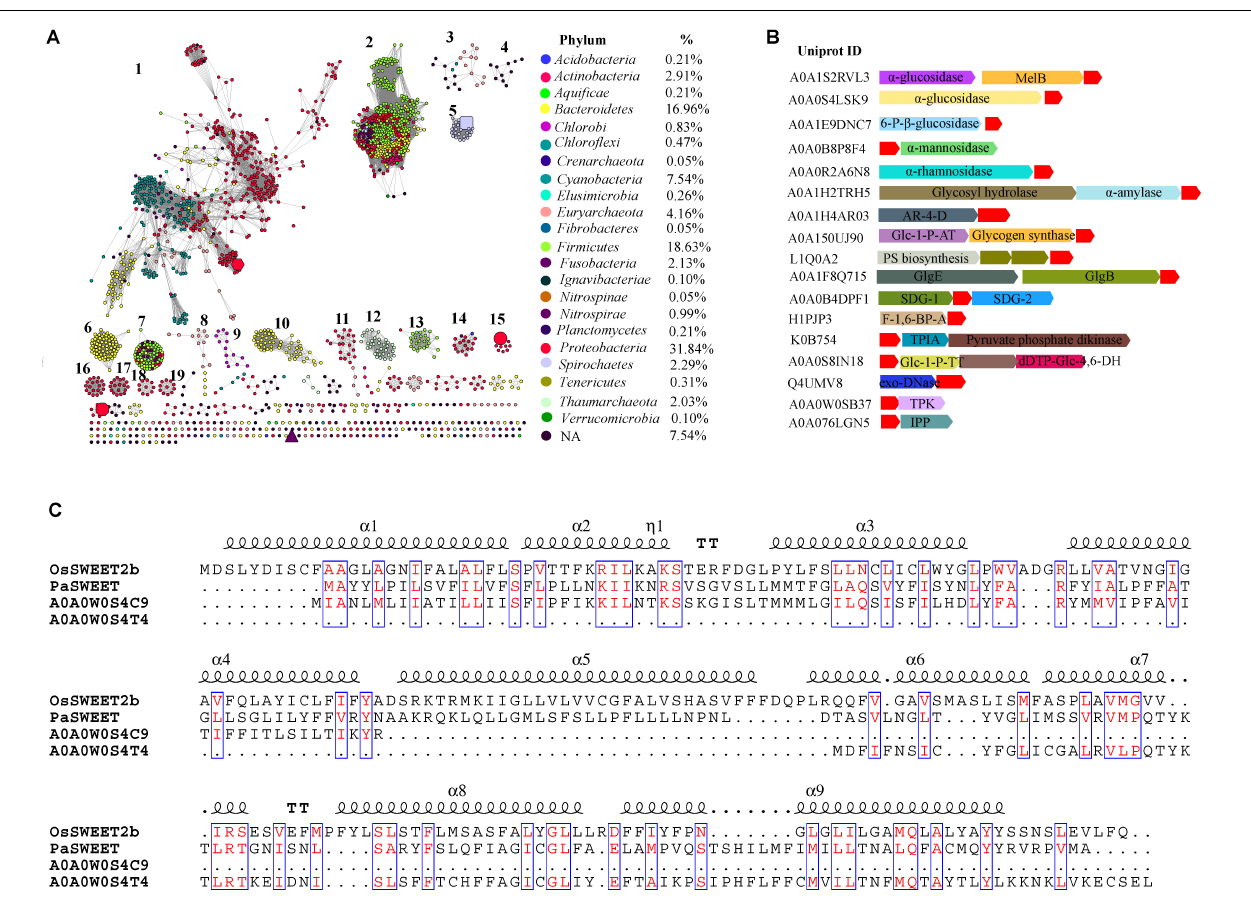
FIGURE 1 | Global view of sequence diversity of SemiSWEETs. (A) The protein sequence similarity network (SSN) of SemiSWEETs from prokaryotes. 1,922 protein sequences were analyzed by means of an SSN with an e-value threshold of 10 − 25 ( > 50% sequence identity). Each node represents one protein. Edges are shown with BLASTP e-values below the indicated cut-off. A cluster was sequentially labeled if there were more than 10 nodes in it. Nodes from the same phyla in the global network have the same color. The colors corresponding to each class and protein percentage in each class are listed at the bottom. BjSemiSWEET (hexagon), LbSemiSWEET (rectangle), EcSemiSWEET (octagon), TySemiSWEET (triangle), and VsSemiSWEET (cycle) are enlarged. (B) Schematic view of the genomic context of SemiSWEETs. The UniProt IDs of the SemiSWEETs are listed on the left. The SemiSWEETs or SWEETs are shown in red. The annotated names of other genes are shown on the genes. The abbreviations are AR-4- D , D -arabinitol 4-dehydrogenase; Glc-1-P-AT, glucose-1-phosphate adenylyltransferase; PS biosynthesis, polysaccharide synthesis; GlgB, 1,4- α -glucan branching enzyme; GlgE, α -1,4-glucan:maltose-1-phosphate maltosyltransferase; SDG, saccharopine dehydrogenase; F-1,6-BP-A, fructose-1,6-bisphosphate aldolase; TPIA, triosephosphate isomerase; Glc-1-P-TT, glucose-1-phosphate thymidylyltransferase; dTDP-Glc-4,6-DH, dTDP-glucose 4,6-dehydratase; TPK, thiamin pyrophosphokinase; IPP, inositol-phosphate phosphatase. (C) Sequence alignment